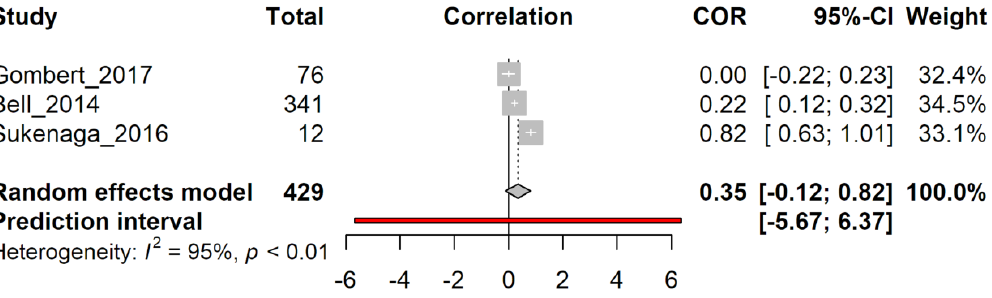
Figure 5. Random effect model analysis of group 2 ’s papers. Study: the first author followed by the year of the study examined. Total: total number of subjects in each group. COR: correlation (extracted from study) between pain sensations and methylation levels, with confidence intervals (grey squares). A 95%-CI: confidence interval for 95% on COR. Weight: statistical “weight” for each study. In bold characters, results from random effect model analysis are indicated as a graphical diamond on correlation graph. Heterogeneity: results from heterogeneity test, I 2 , describes the percentage of variation across studies that is due to heterogeneity rather than chance, p : p -value derived from Cochran’s Q test.